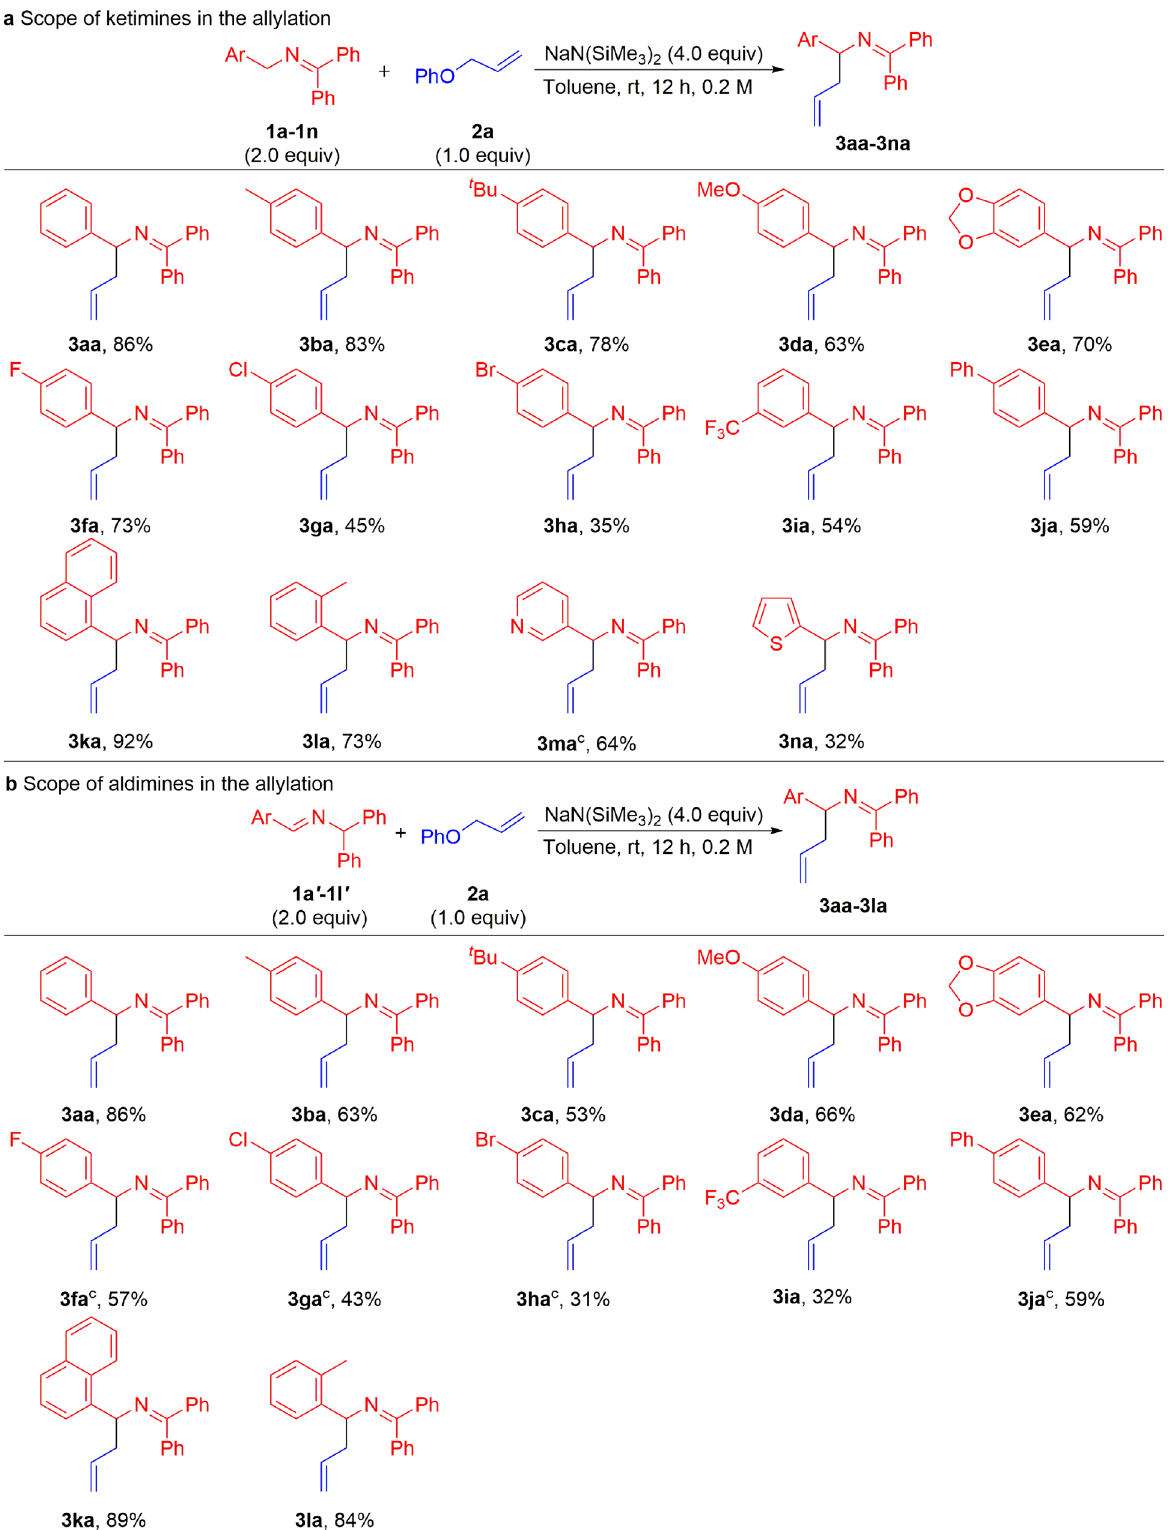
Fig. 3 Substrate scope of imines a,b . a Scope of ketimines in the allylation. b Scope of aldimines in the allylation. a Reactions were conducted on a 0.6 mmol scale using 2.0 equiv. ketimine, 1.0 equiv. 2a , and 4.0 equiv. NaN(SiMe 3 ) 2 at 0.2M. b Yield of isolated product after chromatographic puri fi cation. c At